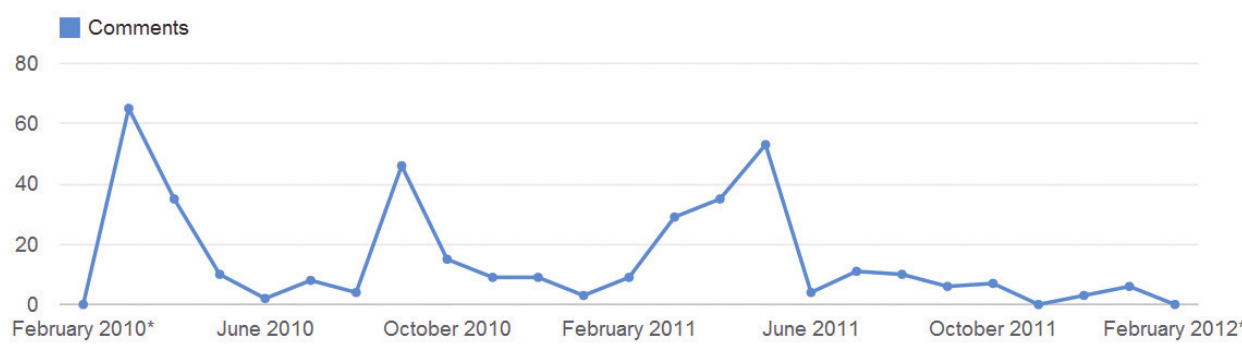
Figure 4. History of the ‘I like’ (blue) versus ‘I don’t like’ reports per month. The total numbers are 990 vs. 26. Most comments were posted in March and May 2011, and January 2012.